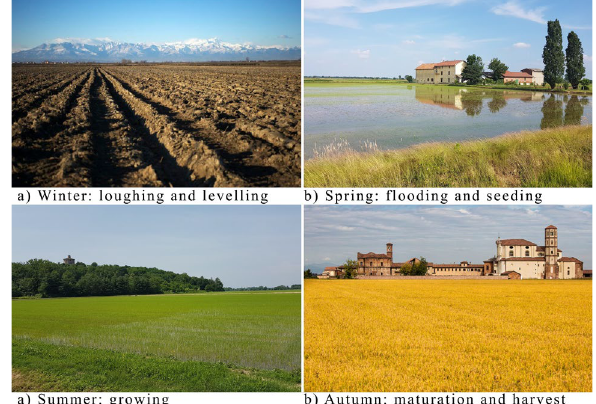
Figure 3. Different landscape conditions of the paddy-rice fields are taken over the seasons.